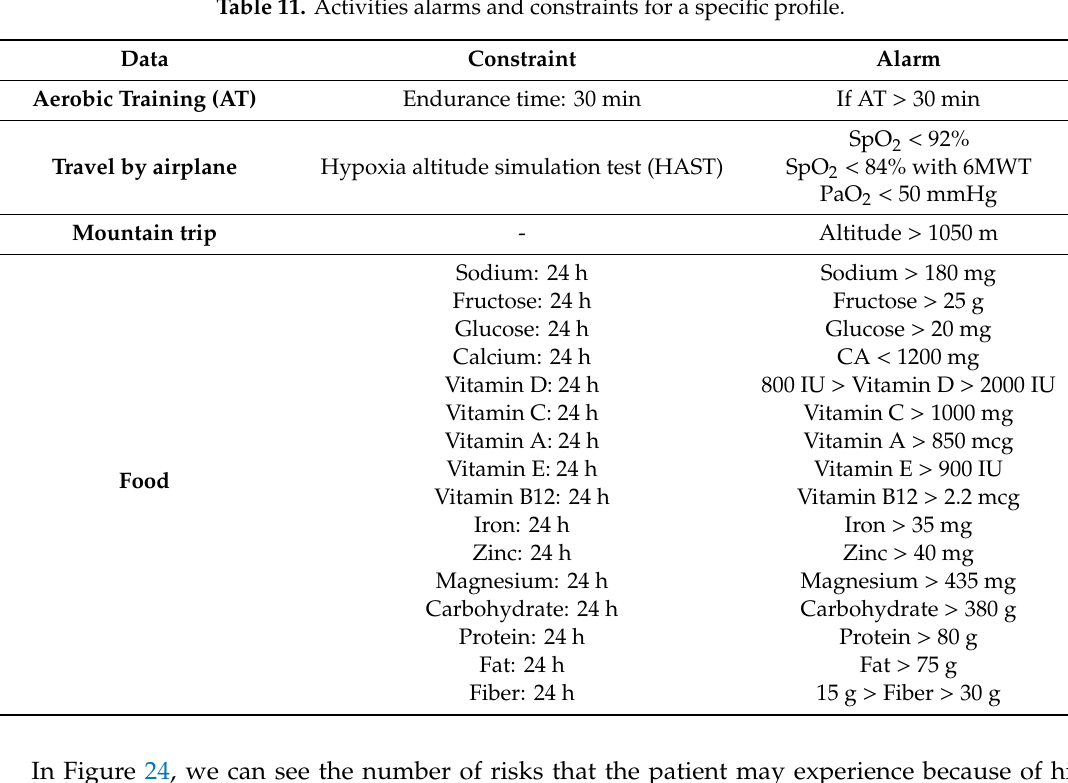
Table 14. Total number of alarms.